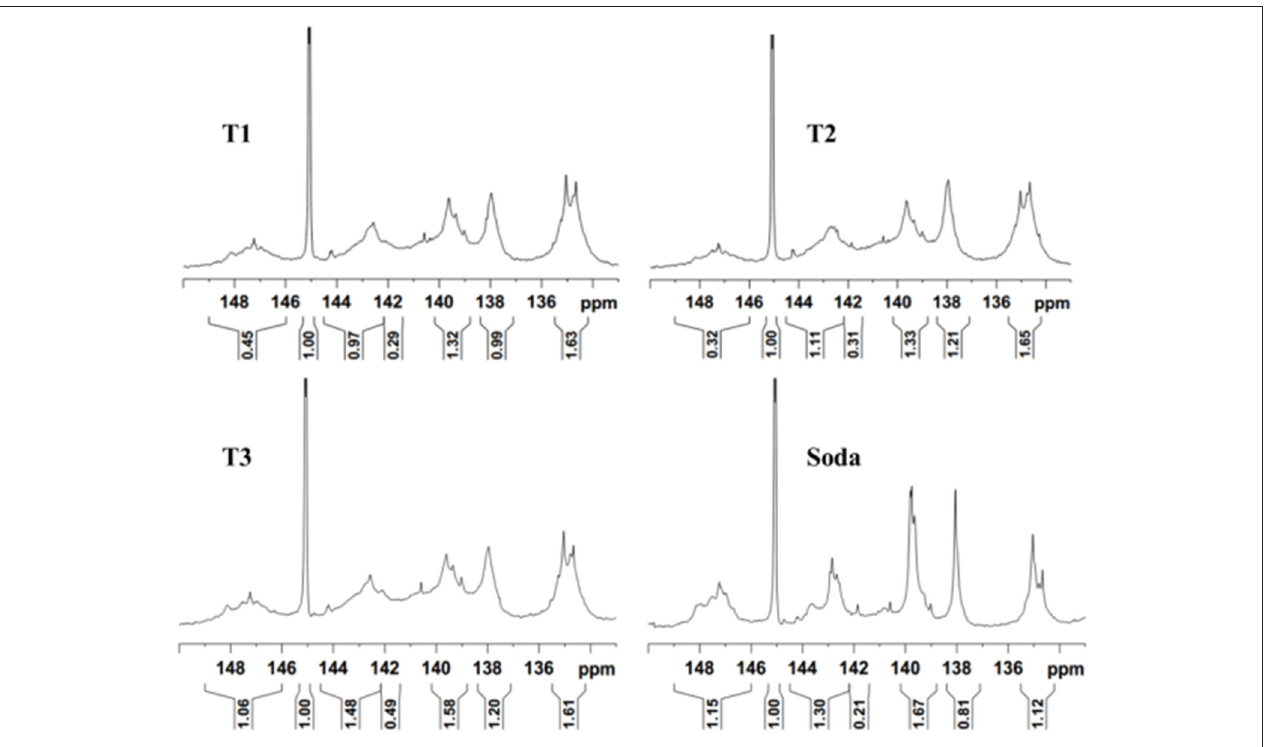
FIGURE 4 | 31 P-NMR spectra of the extracted lignin samples.